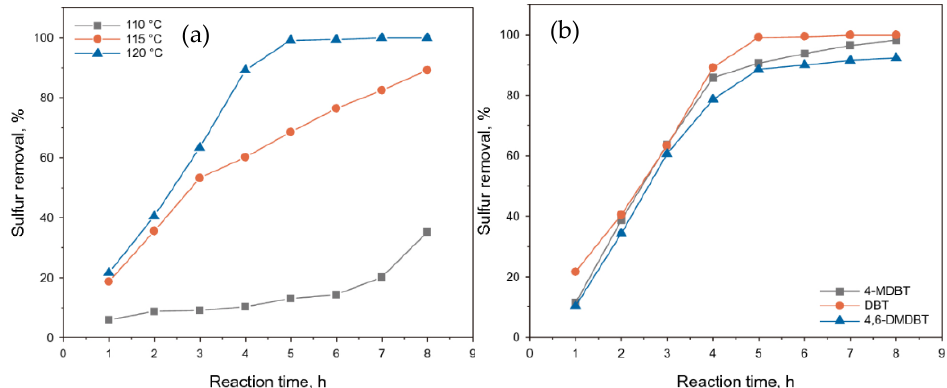
Figure 4. ( a ) Effects of different reaction temperatures on DBT removal. Reaction conditions: m (catalyst) = 0.01 g, air flow = 100 mL/min, and V (model oil) = 20 mL; ( b ) Removal of different substrates in the desulfurization system. Reaction conditions: m (catalyst) = 0.01 g, T = 120 °C, air flow = 100 mL/min, and V (model oil) = 20 mL [72].